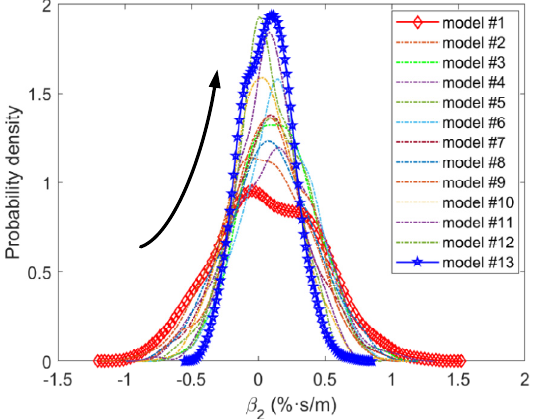
Figure 10. (Color Online) The evolution of posterior distribution of parameter β 2 from the first week to the thirteenth week.